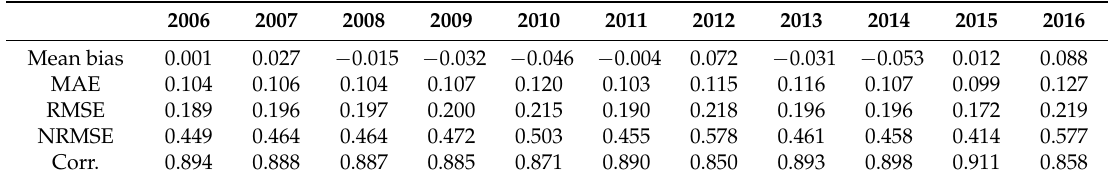
Table 8. Twelve-month averages of validation statistics for sea ice concentration predicted by the DNN with BMA2 ensemble for the Kara and Barents Seas during